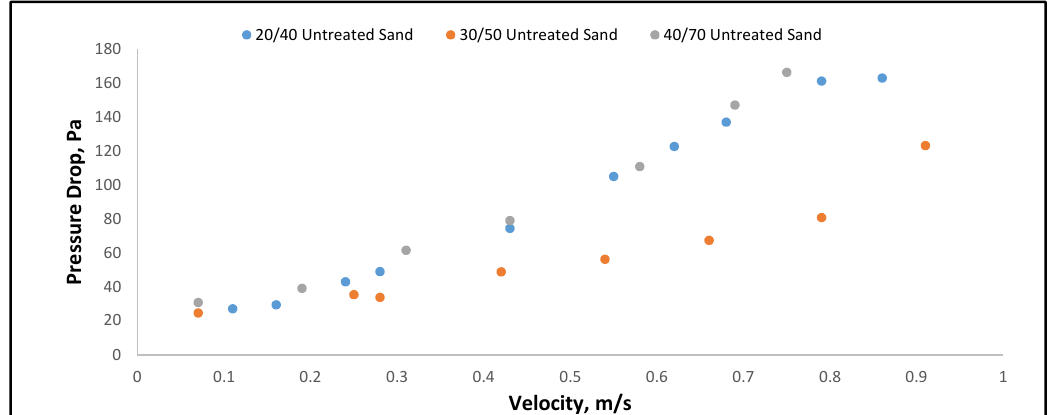
Figure 6. Frictional pressure drop measured for the flow of the polymer fluid over the sand bed of 3 different particle size ranges.